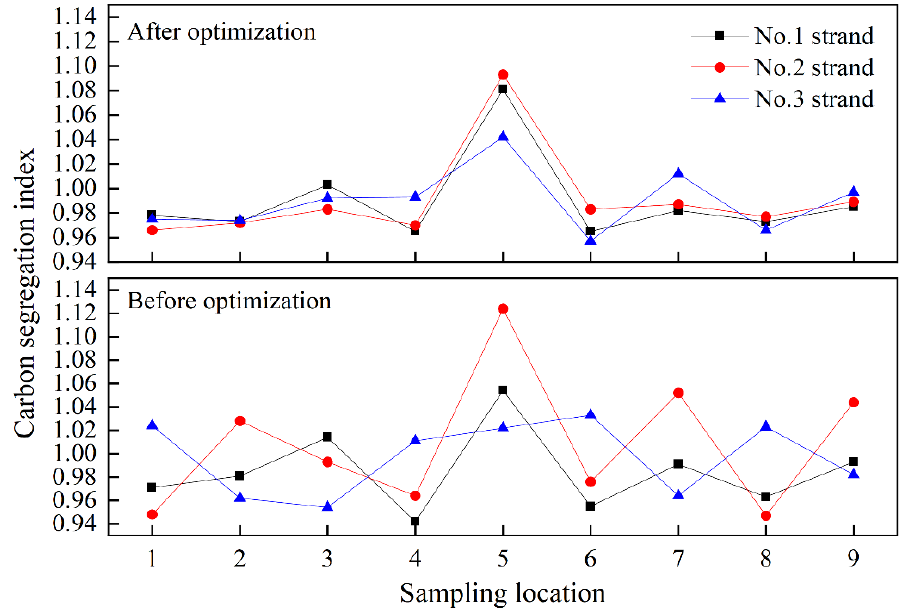
Figure 10. Carbon segregation index before and after optimization.